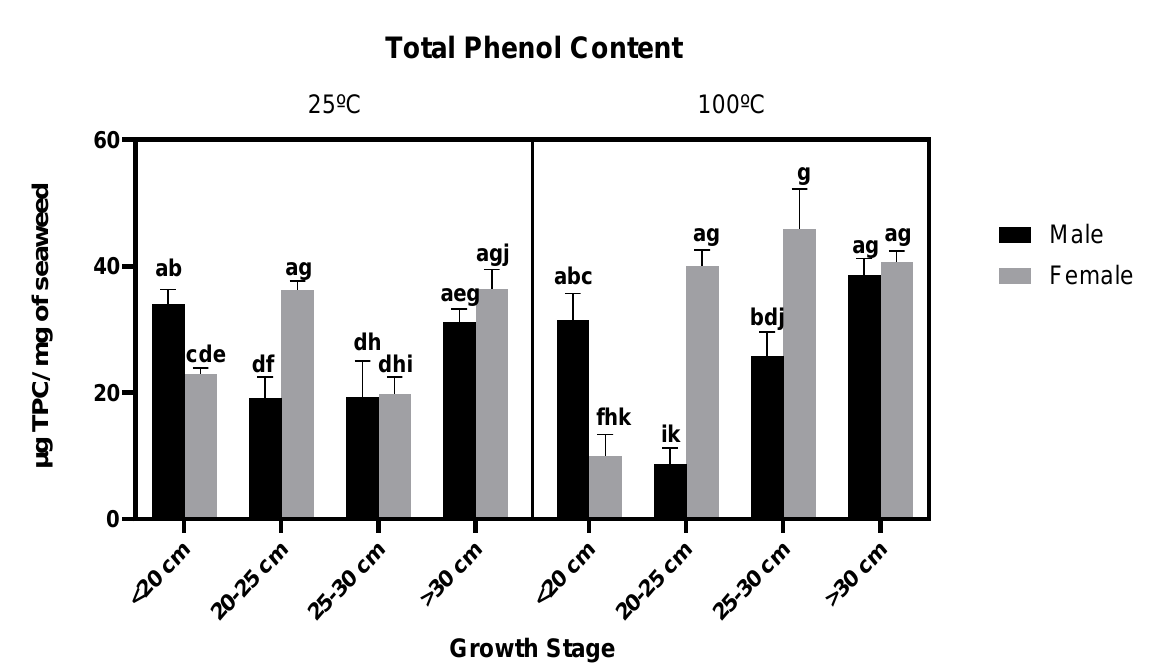
Figure 1. Total phenol content in a milligram of different F. vesiculosus extracts according to their gender, growth stage (µg TPC/mg of seaweed) and temperature of extraction (25 °C and 100 °C). Different superscript letters (a–i) correspond to values that can be considered statistically different ( p -value ≤ 0.05). A three-way ANOVA was carried out for statistical analysis between gender, growth stage and temperature of extraction with Tukey’s HSD test for multiple comparisons represented by the superscripted letters.